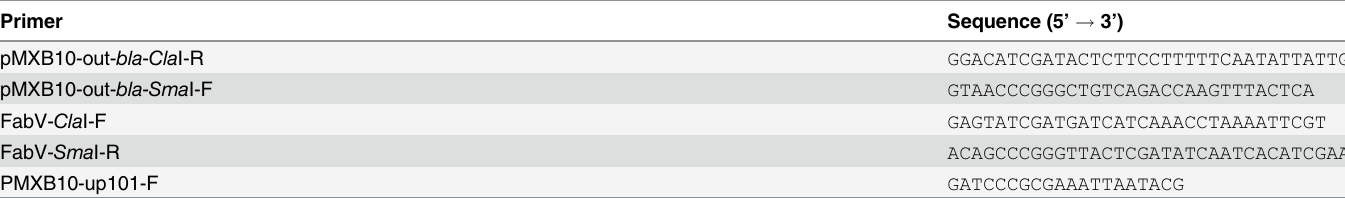
Table 2. Oligonucleotides used to construct vectors used in this